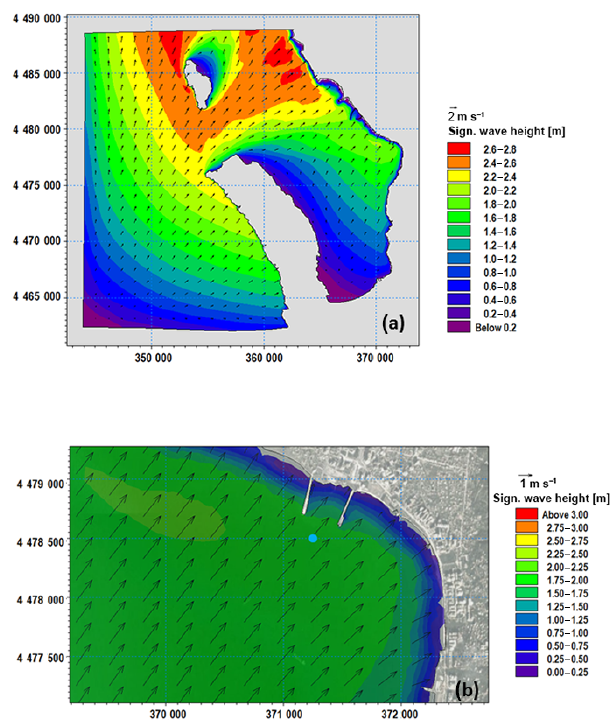
Figure 9. Wave field for the design wave condition generated by southern wind U = 41ms − 1 , Dir 215 ◦ N, T R = 100 years. (a) En- tire domain, (b) harbour entrance. The blue bullet is the extraction point location; its UTM coordinates are 371221 ◦ E, 4478470 ◦